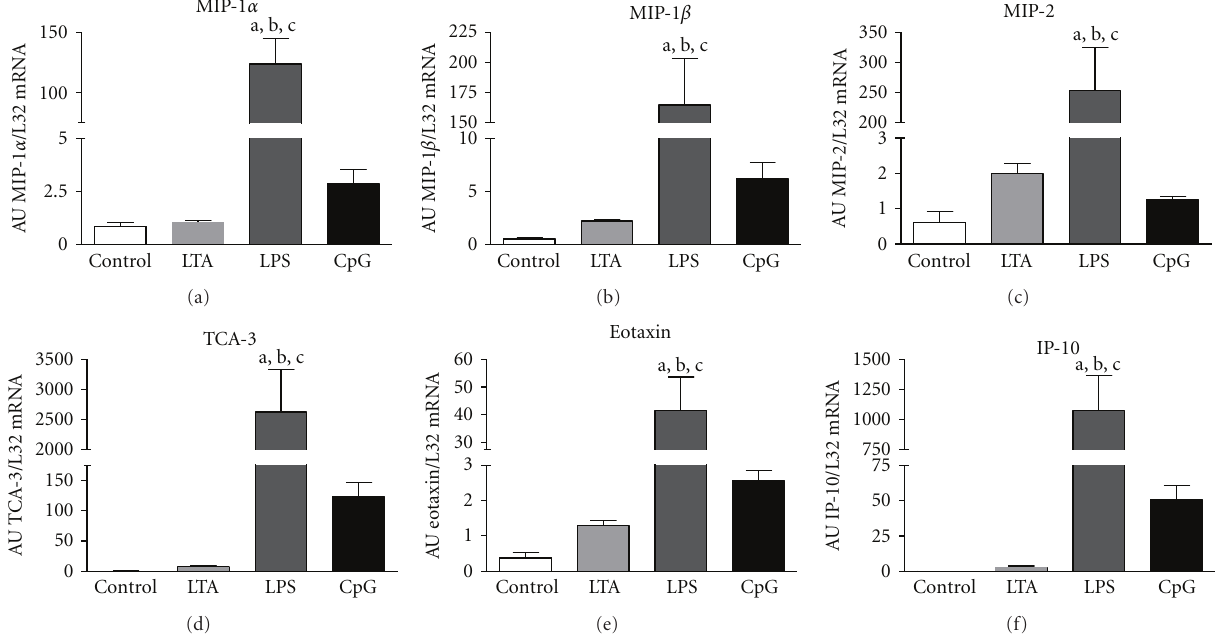
Figure 4: Chemokine mRNA expression. Densitometric analysis of MIP-1 α , MIP-1 β , MIP-2, TCA-3, eotaxin, and IP-10 in control, LTA-, LPS-, and CpG-ODN-stimulated pulmonary tissue. Values of mRNA expressions are normalized to L32 and expressed as arbitrary units (AU). Alphabetic characters indicate P -values < . 05 from Bonferroni post-hoc testing (a = versus control, b = versus LTA, c = versus CpG- ODN; n = 4, M ± SEM; n = 6/group).